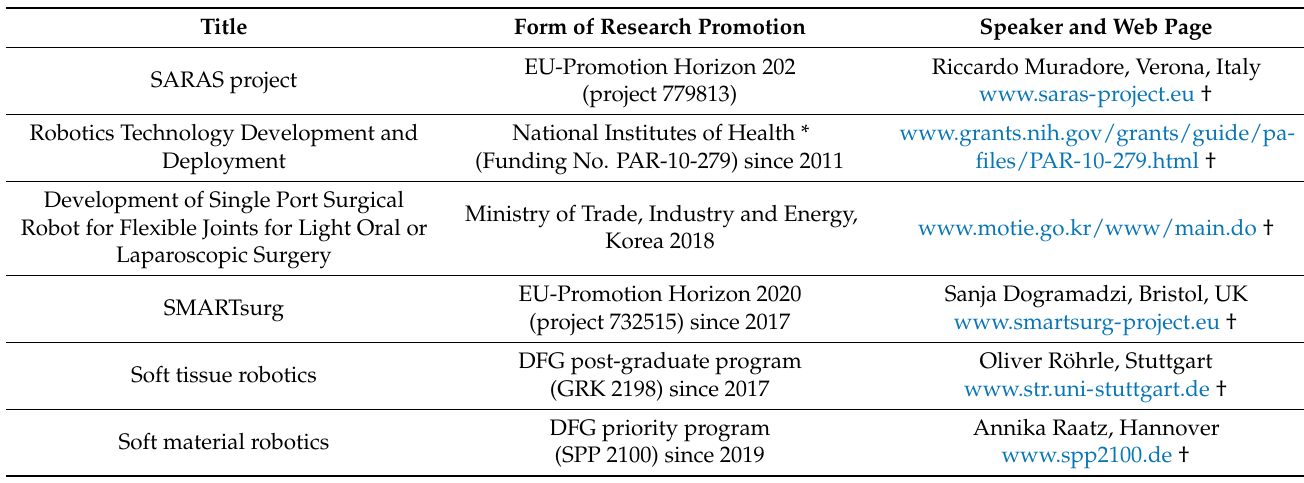
Table 3. Research initiatives with a focus on